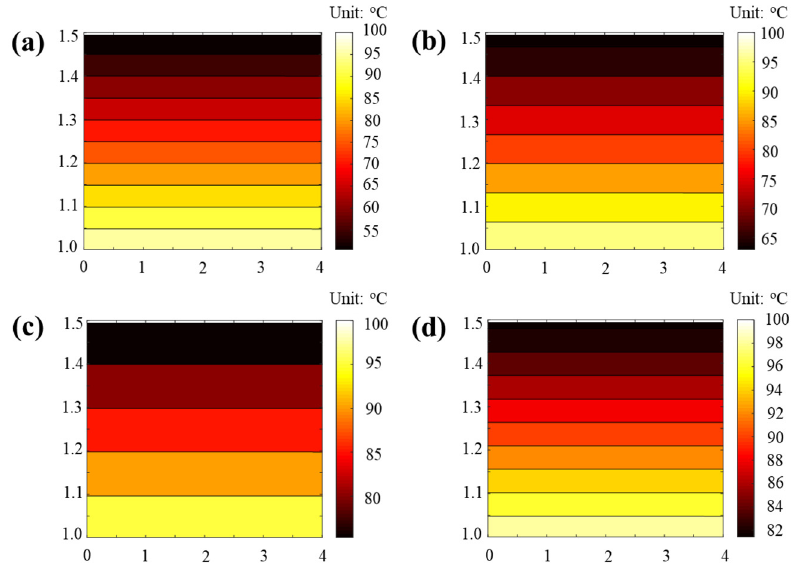
Figure 9. Simulation results of interpolate temperature and contour temperature distribution across the sample for different cases of thermal conductivity enhancement: ( a ) K = 0.2 W/mK; ( b ) K = 0.3 W/mK; ( c ) K = 0.4 W/mK; and ( d ) K = 0.8 W/mK (the unit of the vertical and horizontal axes is millimeters (mm)).